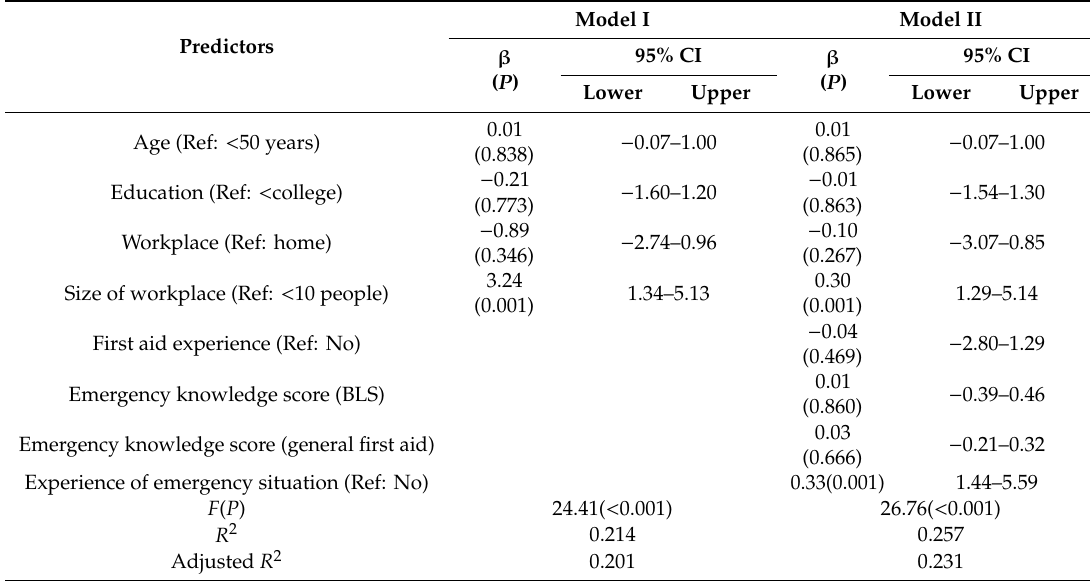
Table 4. Regression analysis for predictive factors of ability to cope with emergencies ( N =